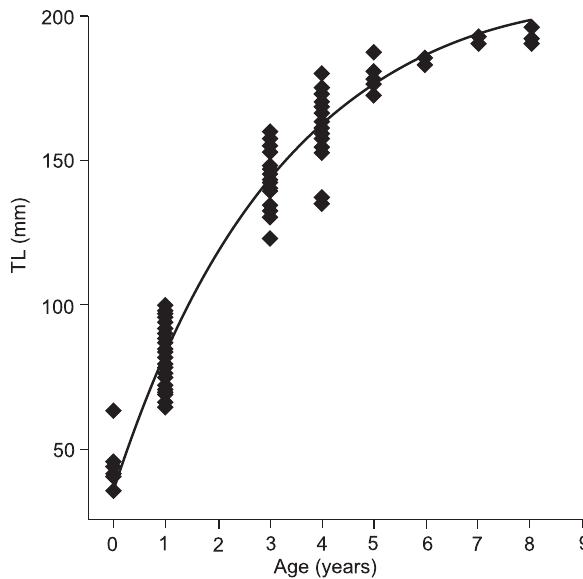
Figure 7. Trachurus lathami: von Bertalanffy growth curve fitted (line) to observed total lengths (points) by age (n = 278).